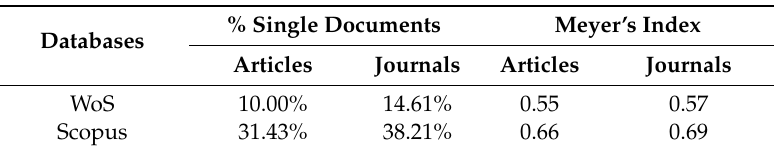
Figure 5. Overlap data between WoS and Scopus. Source: The authors’ own elaboration. Table 4. Singularity of the